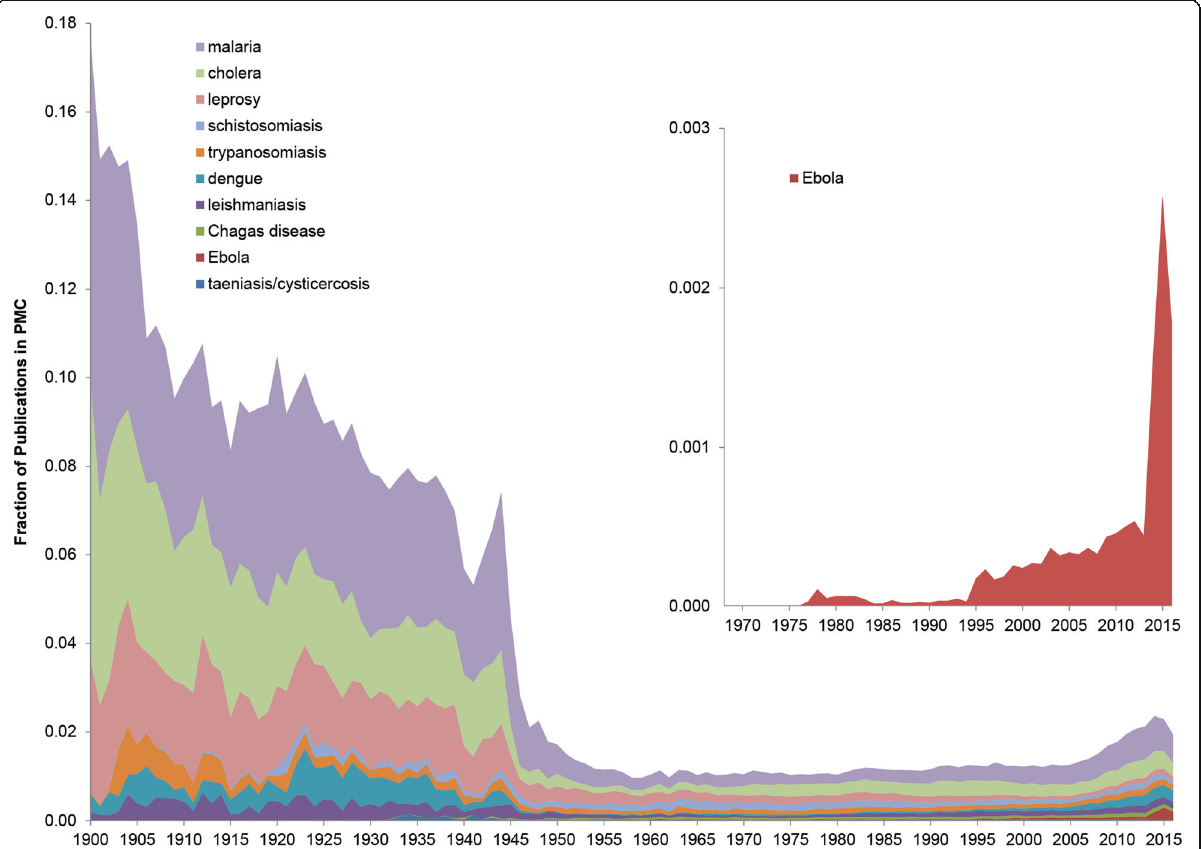
Fig. 3 Publication on tropical diseases 1900 – 2016. Publications on the 10 most published on tropical diseases between 1900 and 2016. The magnified region in the inset shows the relative number of publications on Ebola since the first outbreak in